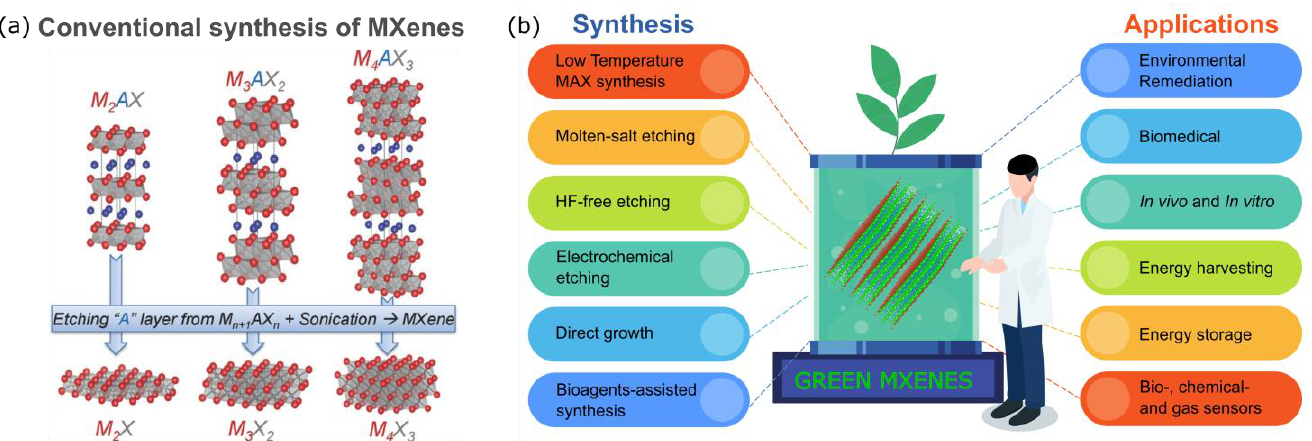
Figure 1. ( a ). Crystal structure transformation of MAX phase and their conventional exfoliation into MXenes. Adopted from reference [3]. ( b ) Green route to synthesize MXenes and their potential ap- plications.